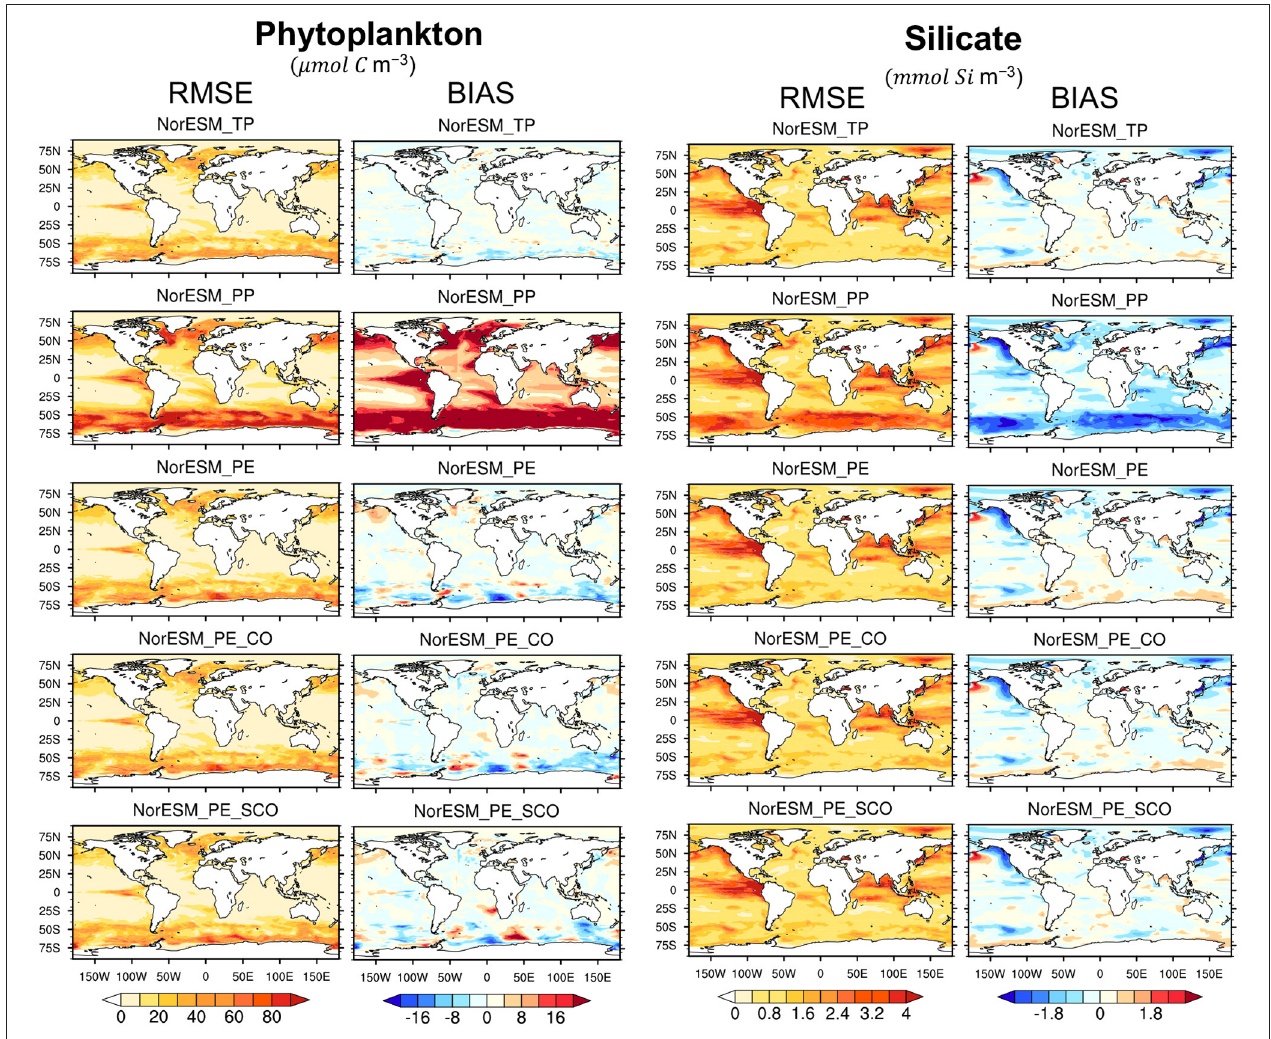
FIGURE 10 | RMSE and bias maps estimated over 1980–1983 for phytoplankton and silicate. For phytoplankton, RMSE (column-one) and bias (column-two) are averaged over euphotic zone (0–100 m), while for silicate, they are averaged over 0–500m depth (column-three and -four, respectively). The error are computed from free NorESM simulation using TP (first row), PP (row-two), and fixed PE estimated with assimilation of time-varying observation (row-three), time varying physic and climatological BGC (row-four), and time varying physic and sparse climatological BGC